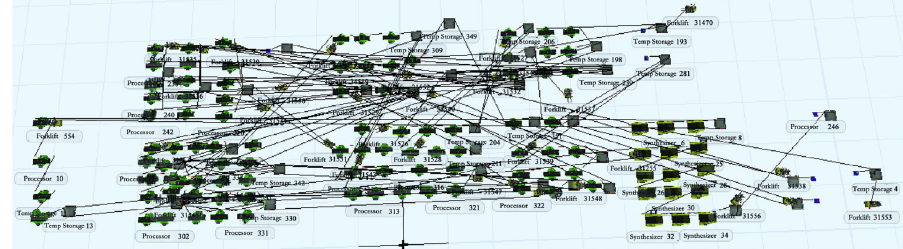
Fig 11. Simulation model of the original layout logistics system of the bearing